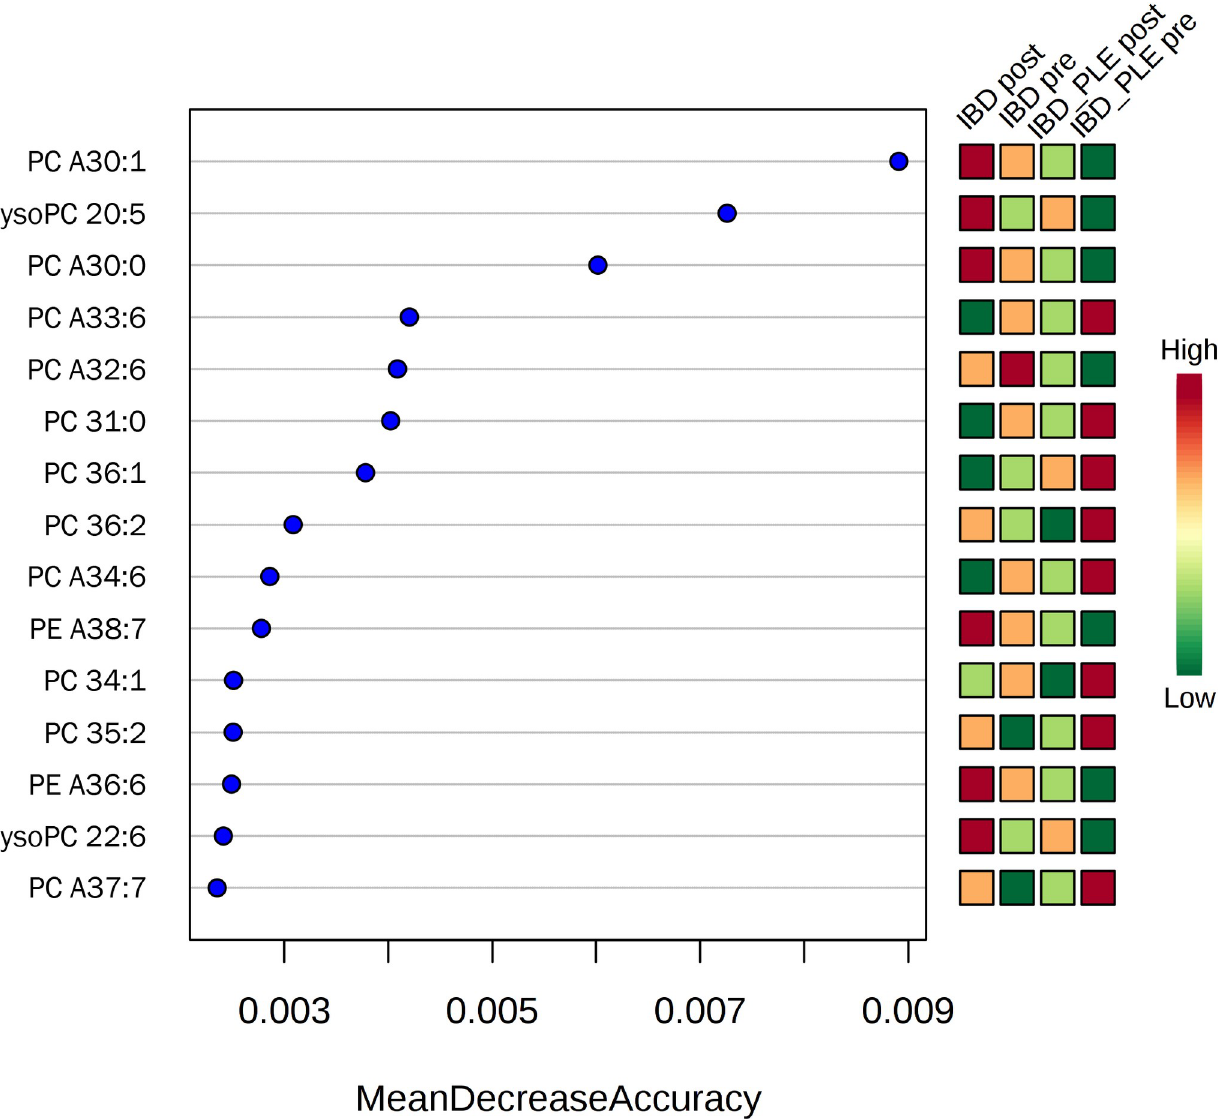
Fig 6. Random forest analysis of phospholipids and their association with treatment in IBD. The 15 top phospholipids based on their importance to discriminate between the treatment statuses of dogs with IBD are shown. Red boxes represent a high abundance, green boxes a low abundance of a given phospholipid. PC, phosphatidylcholine; PE, phosphatidylethanolamine; ’A’ indicates an ether species; the XX:y notation specifies the total number of carbon atoms in the radyl chains (’XX’) followed by the number of unsaturation (’y’).